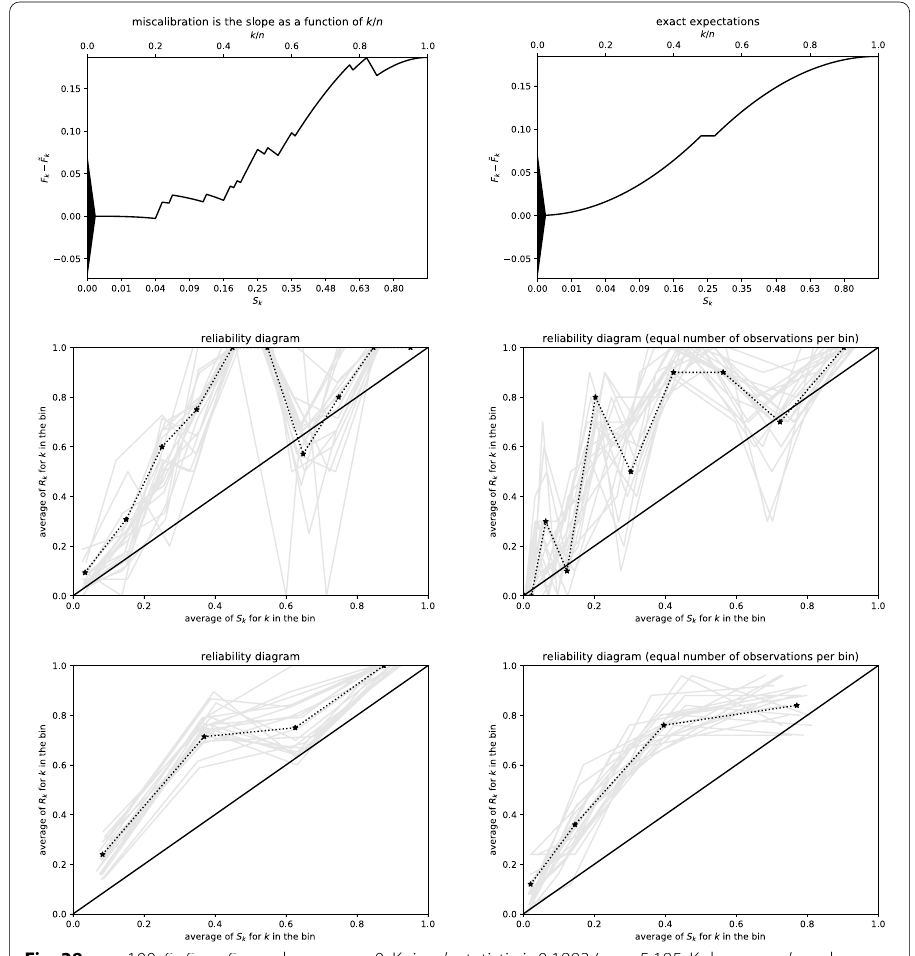
Fig. 38 n = 100; S 1 , S 2 , ..., S n are denser near 0; Kuiper’s statistic is 0.1893 /σ = 5.185 , Kolmogorov’s and Smirnov’s is 0.1867 /σ = 5.112 . Figure 39 displays the ground-truth reliability diagram. The plots, whether cumulative or conventional, reveal similar information here, though the reliability diagrams with an equal number of observations per bin provide more reliable estimates than the other reliability diagrams. The cumulative plot is perhaps the easiest to interpret: the miscalibration is significant for 0.1 (cid:31) S k (cid:31) 0.23 and 0.27 (cid:31) S k (cid:31) 0.6 , with about the correct amount of miscalibration (the amount is correct since the secant lines have the expected